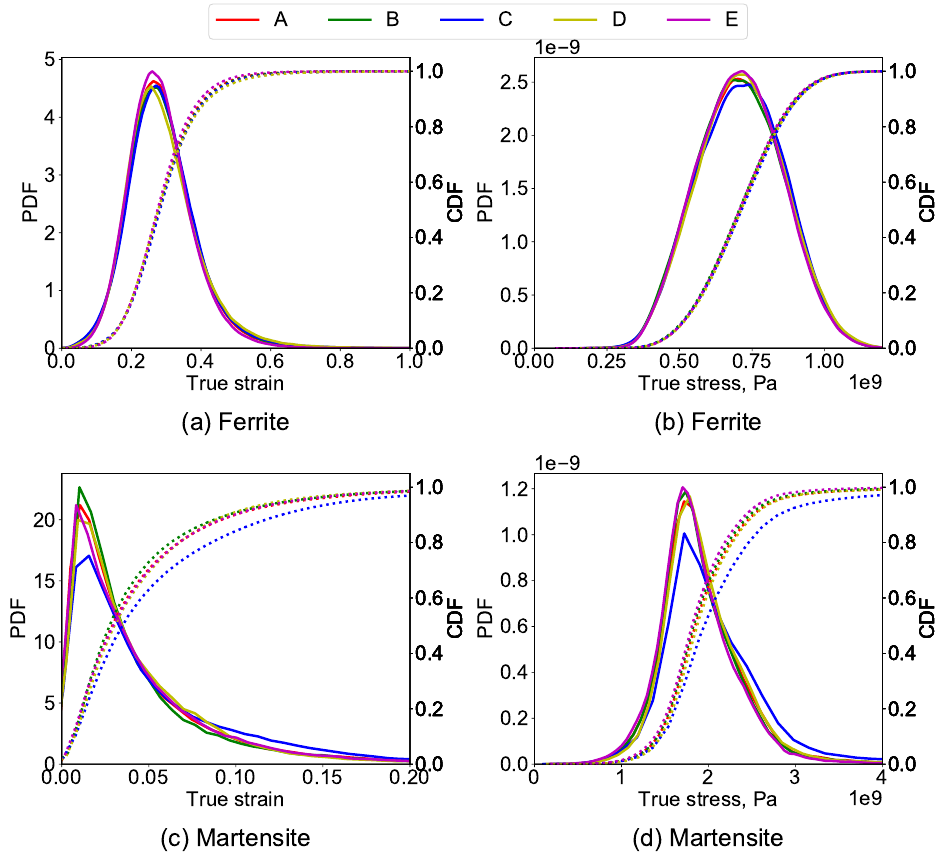
Figure 8. Comparison of ( a ) local strain distribution in ferrite, ( b ) local stress distribution in ferrite, ( c ) local strain distribution in martensite, and ( d ) local stress distribution in martensite, using PDF and CDF curves for RVEs with varying D f at 25% of global true